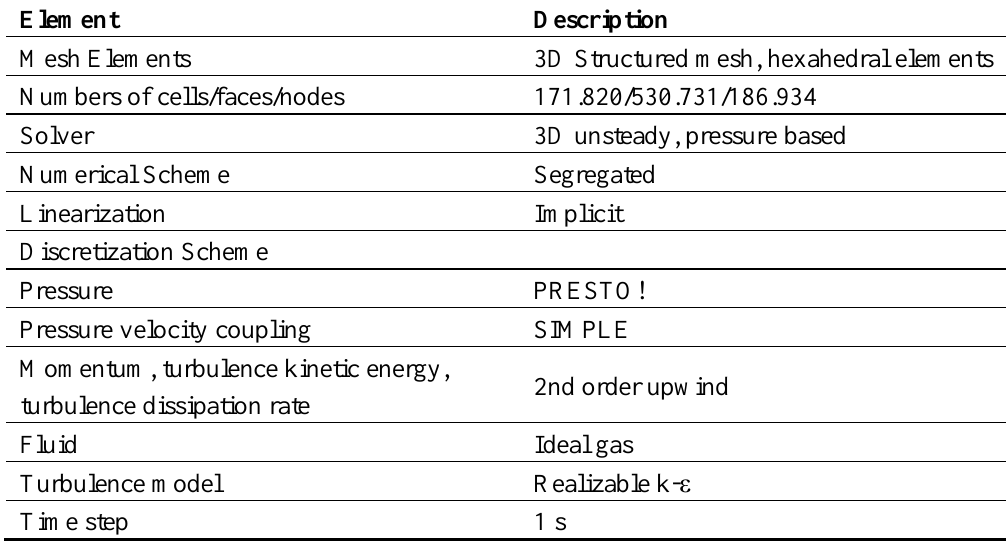
Table 1. Details of CFD